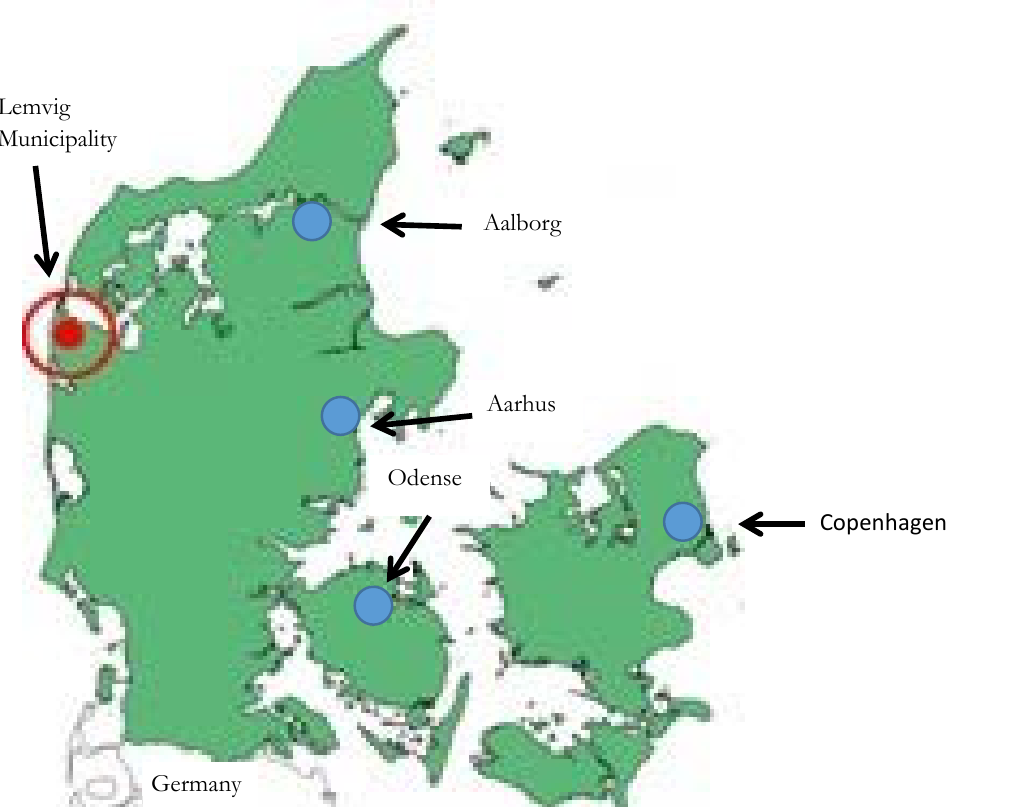
Figure 1. Map of Denmark and Lemvig Municipality in the peninsular of Jutland, as well of the four largest cities in